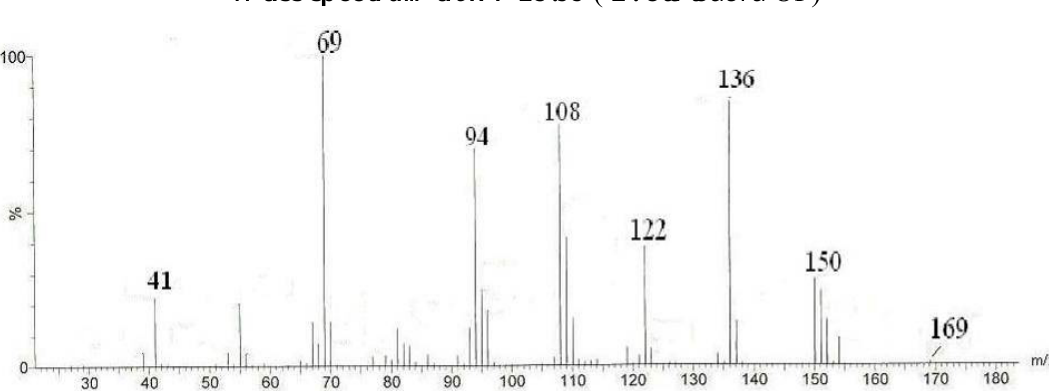
Figure 2. Mass spectrum of compound 2a (Isomer I) citronellal oxime (I). Mass spectrum at RT 23.99 ( E. citriodora